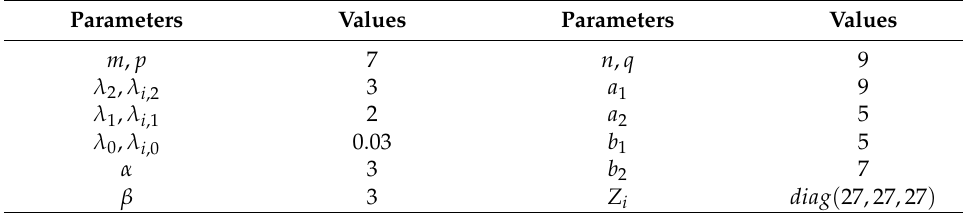
Table 3. Parameter values.